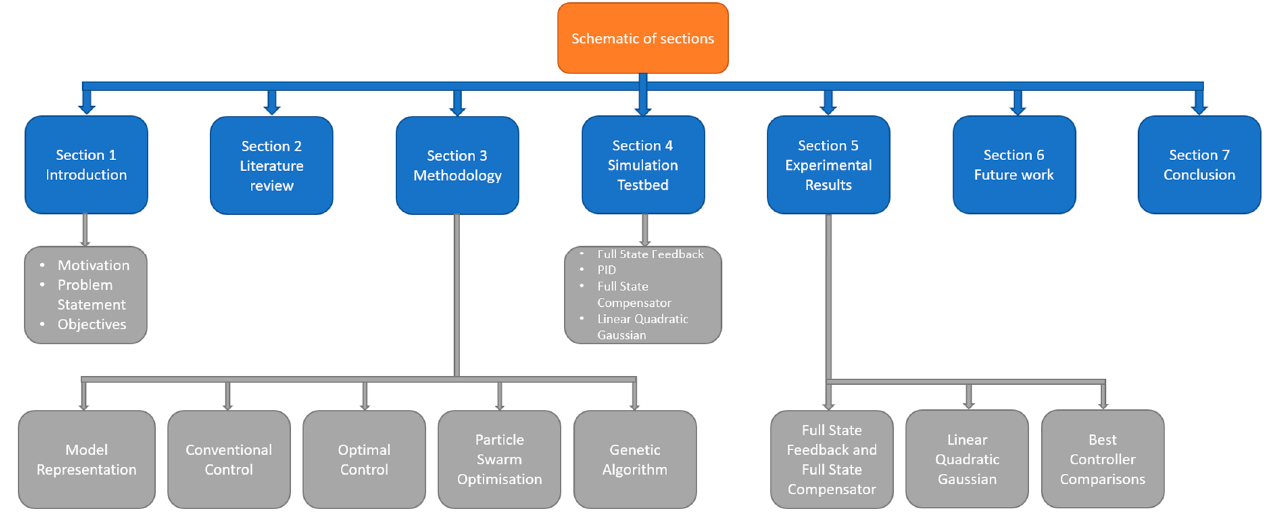
Figure 1. Schematic of sections in this work.